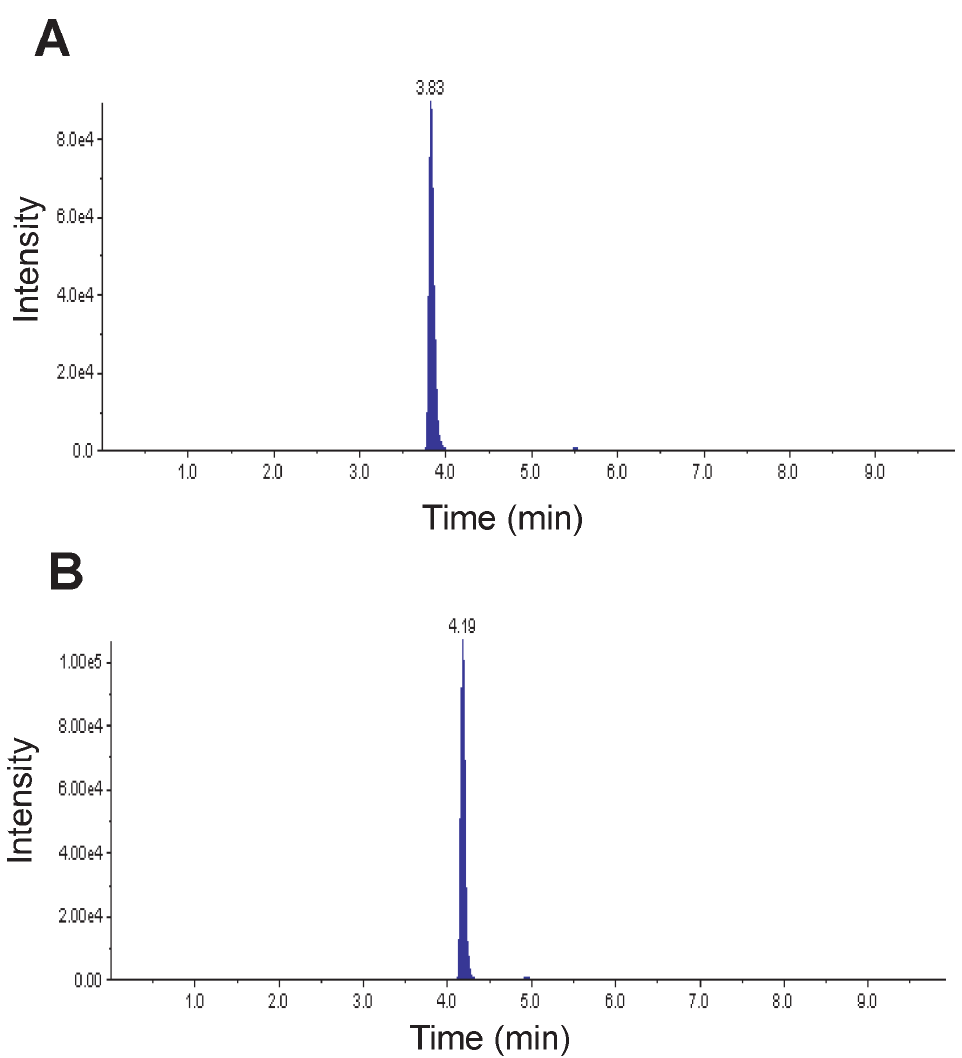
Figure 5. MRM chromatograms. Chromatograms of thiamethoxam (A) and its metabolite clothianidin (B) in 13,400 pea aphid larvae exposed to thiamethoxam at LC 50 for 48 h. Intensity represents the peak area of the detected signal.